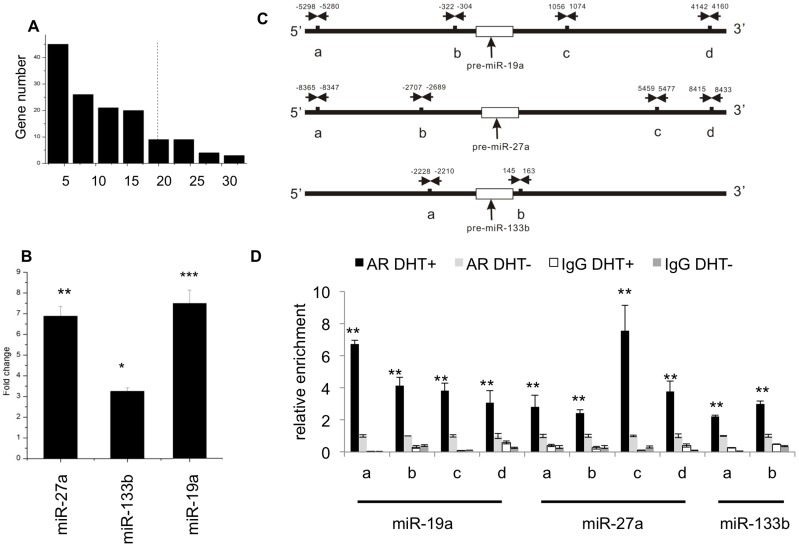
Novel identification of AR target miRNAs.
Figure 3A. RS distribution of androgen-responsive miRNAs. miRNA numbers according to different RS values are presented, the dashed line denotes the threshold for identifying AR candidate primary target miRNAs. Figure 3B. RT-PCR analysis for identified AR candidate target miRNAs. Fold change of DHT-treated LNCaP cells over control samples was presented with significance assessment (in this study, *: p<0.05; **: p<0.01; ***: p<0.001). Fold change in control samples was deemed as 1 for all RT-PCR analyses in this study. This figure is the RT-PCR analysis of miRNAs at 40 min of DHT stimulation. Figure 3C. Schematic diagram of miR-133b, miR-19a, and miR-27a’s ARE location in the 5′ and 3′ regions. The horizontal arrows indicate the approximate ARE locations. Figure 3D. ChIP assay of AR-binding on candidate targets of miR133b, miR19a, miR27a. ‘IgG’ serves as the negative control for ChIP assay.